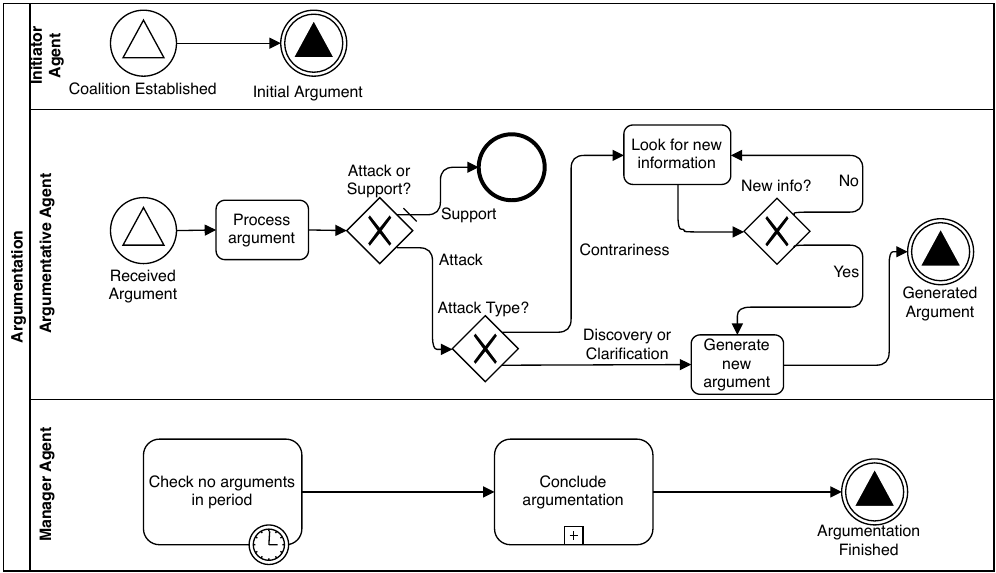
Figure 4. Argumentation